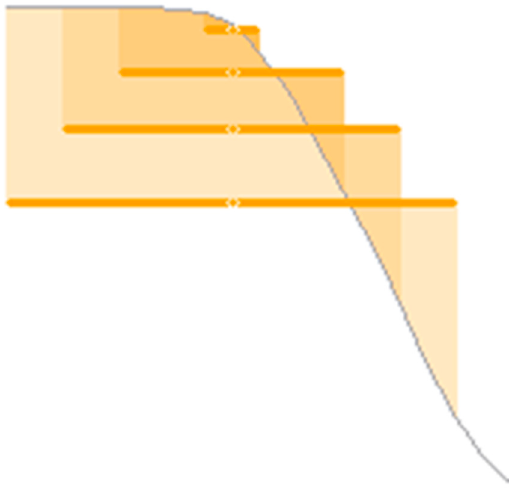
Figure 5. Plotting mean of values with the same midpoint from cup measurements.